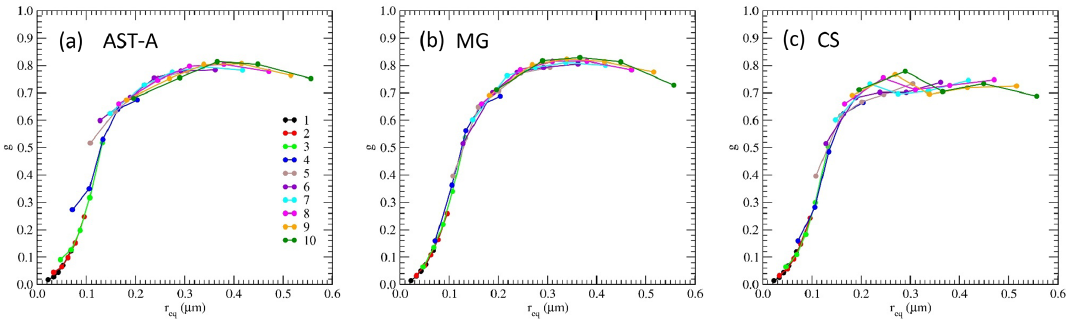
Figure 7. As Fig. 6, but for the results of the asymmetry factor g